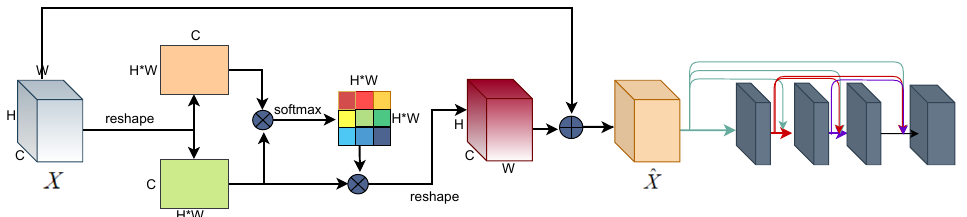
Figure 3. The SADB in the NSRN model ( ⊗ denotes matrix multiplication, and ⊕ denotes element- wise addition).